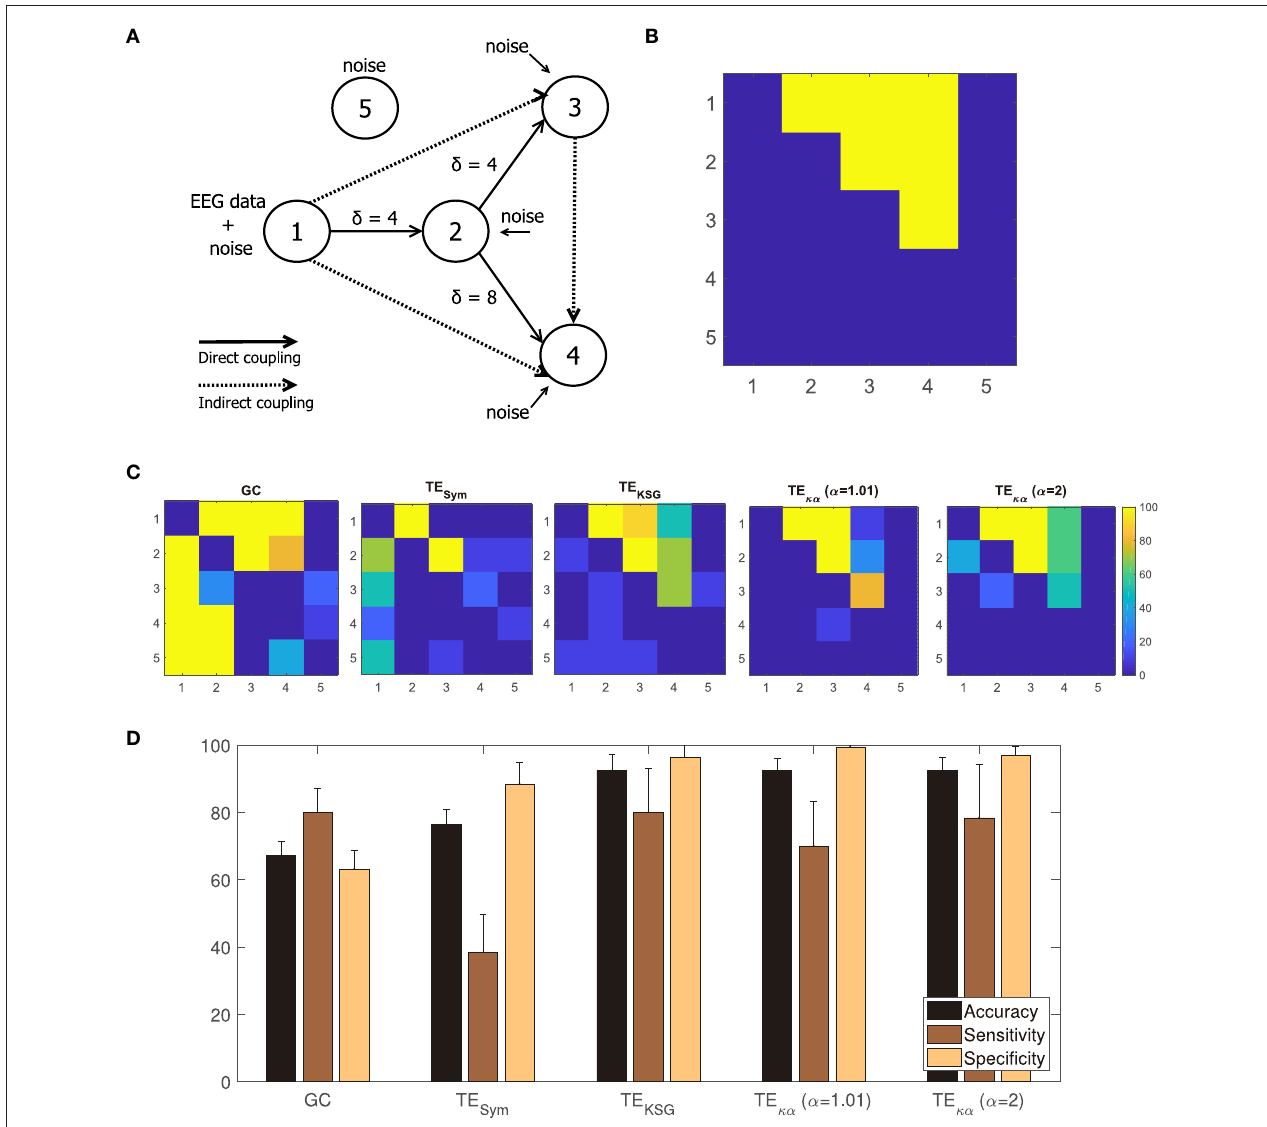
FIGURE 4 | (A) Modified Kus model network coupling scheme. (B) Binary class matrix representation of the direct and indirect couplings in the modified Kus model network. (C) From left to right, statistically significant couplings according to a permutation test using trial randomized surrogates for GC, TE Sym , TE KSG , TE κα ( α = 1.01), and TE κα ( α = 2). (D) Accuracy, sensitivity, and specificity values obtained after comparing the statistically significant couplings shown in (C) with the matrix representation of the Kus model network presented in (A) .